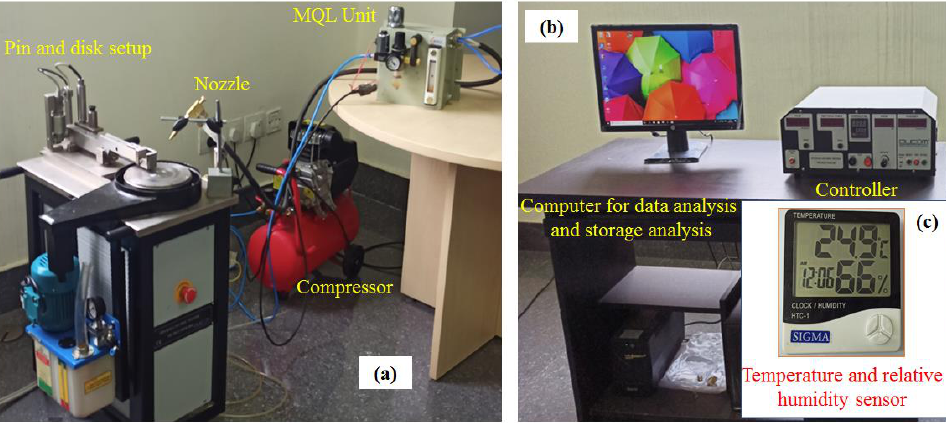
Figure 2. ( a ) Pin-on-disc tribometer setup, ( b ) Control and data analysis system, and ( c ) Temperature and relative humidity sensor showing the ambient conditions.